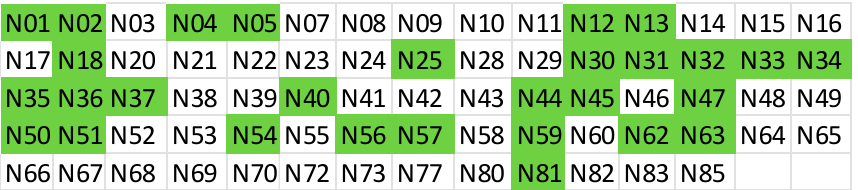
Figure 4. Selected nodes (Green Color) as storm tanks pre-location.